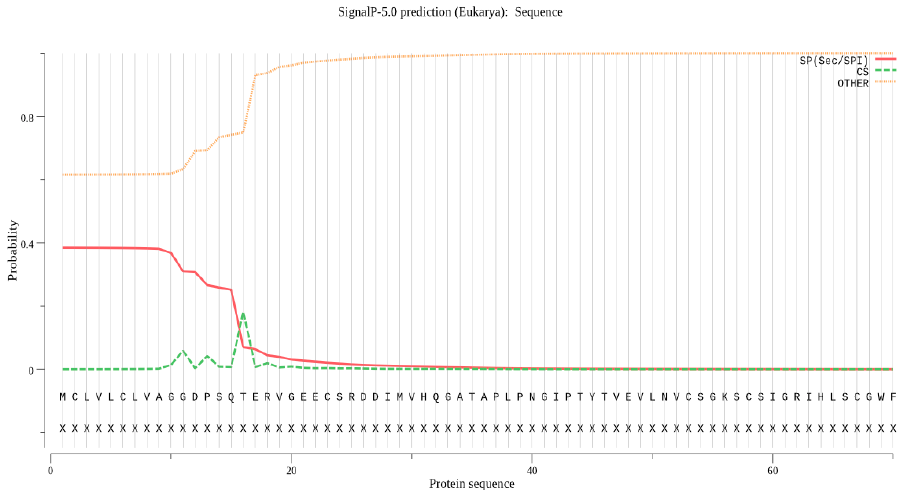
Figure 8. Graphically signal peptide representation of TPD1-like protein.